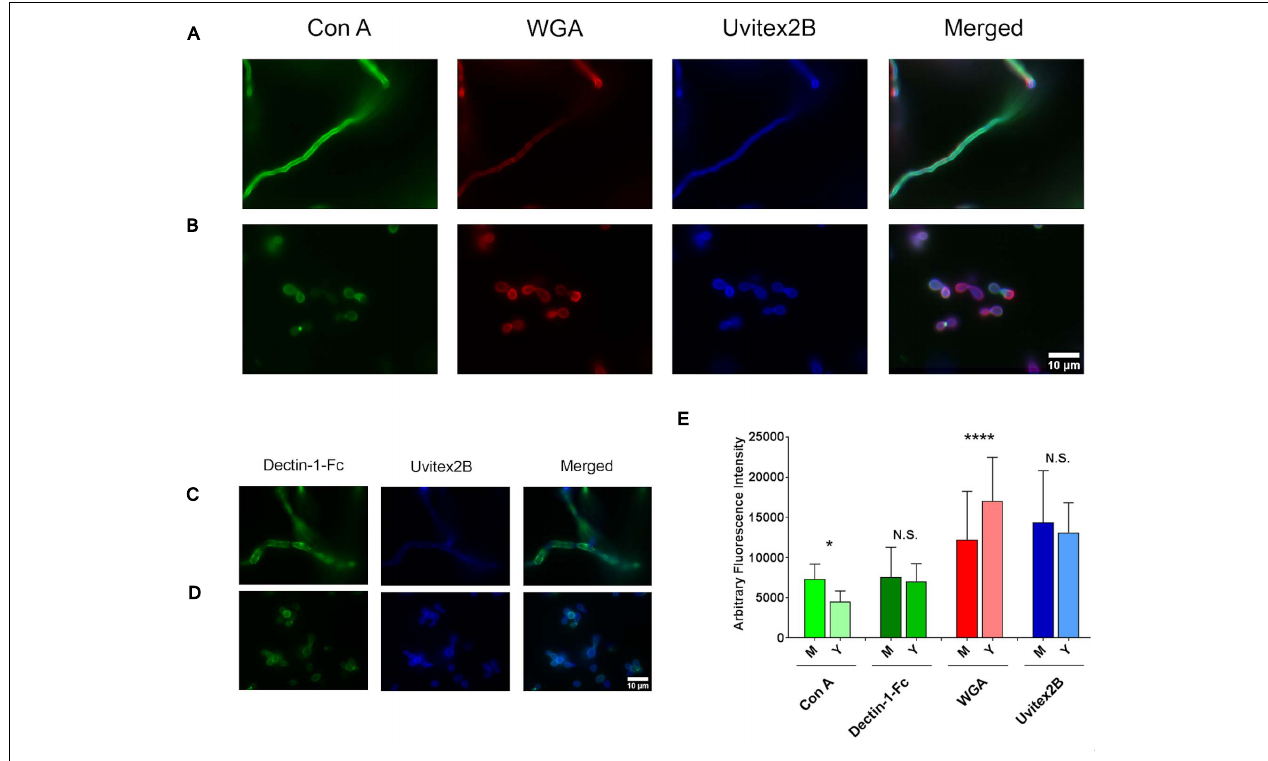
FIGURE 8 | Histoplasma capsulatum cell wall composition from mycelium and yeast cells. Immunofluorescence microscopy showing the labeling pattern of H. capsulatum mycelium (A , C) and yeast cells (B , D) by Con A–FITC, WGA-Fc (Alexa 546), Uvitex 2B, and Dectin-Fc. (E) Arbitrary fluorescence intensity of markers presented in previous panels. N. S., not significant; * p < 0.05; **** p <